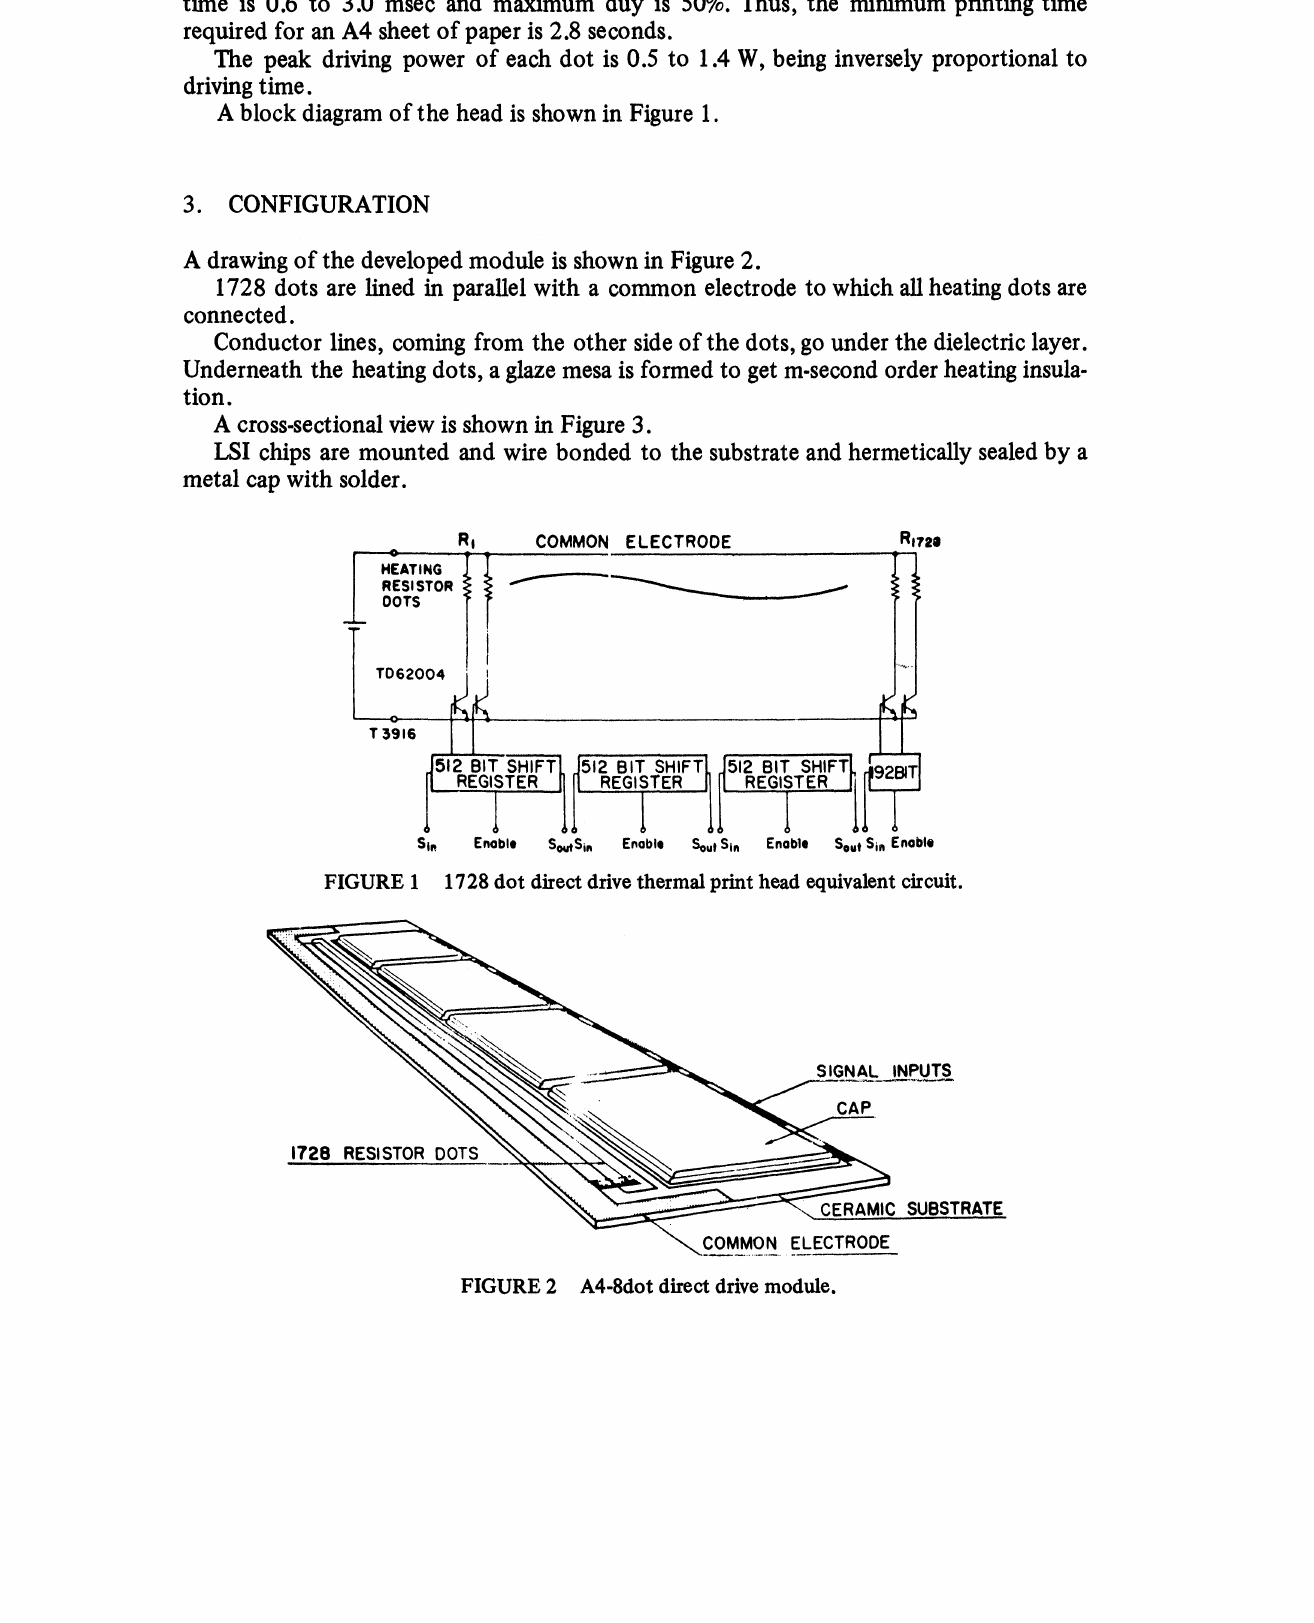
1728 RESISTOR DOTS CERAMI C SUBSTRATE ----\ COMMON ELECTRODE FIGURE 2 A4-8dot direct drive